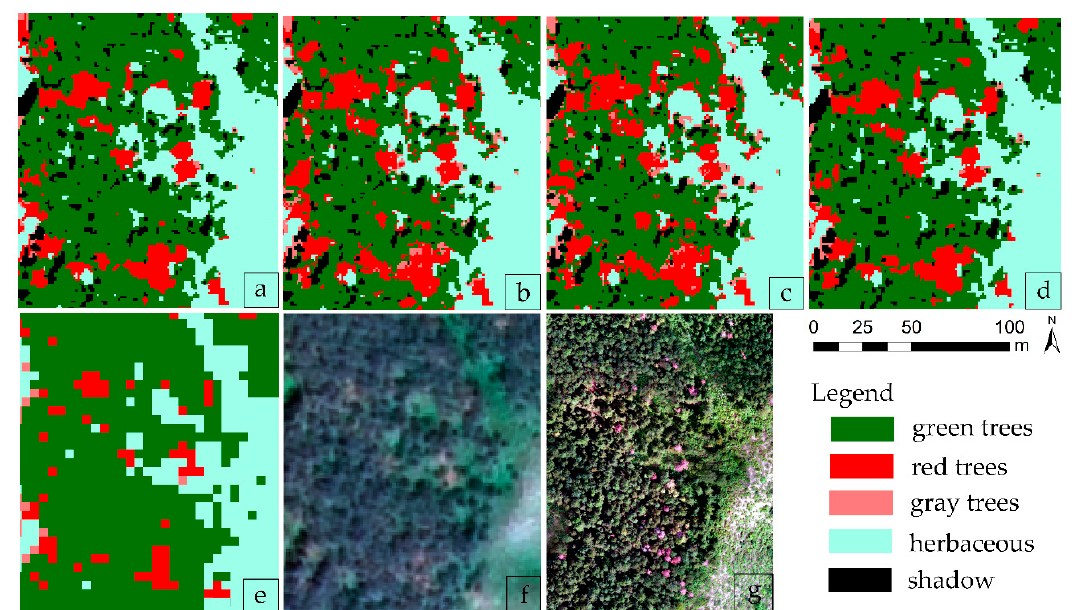
Figure 4. Overall accuracy (OA) of classification for different combinations of resolutions and algorithms using GF2 images, for which the significance level was 0.05. a: 1 m resolution images based on the object method; b: 1 m resolution images based on the pixel method; c: 4 m resolution images. Error bars indicate the standard deviations of 10 classifications. A–D: pairwise differences among combinations of resolutions and algorithms in the classification performance.